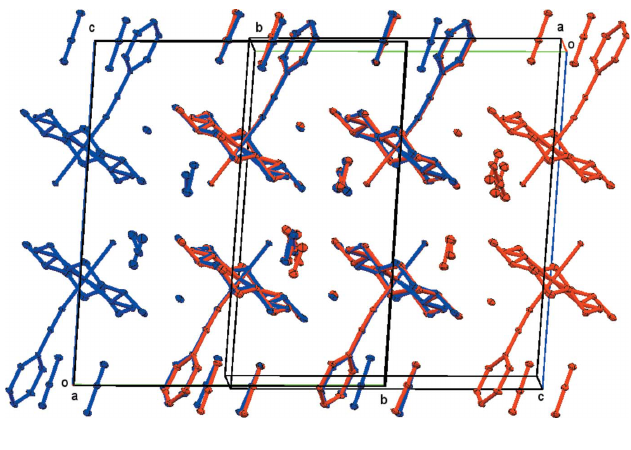
Figure 5 Overlays of a larger segment of the lattice of compound 1 . One of the overlaid cells was inverted for this purpose. The view is along the a axis of the original cell (blue atoms). The overlay is based on a least-squares fit of the four cobalt ions common to the overlaid structures.